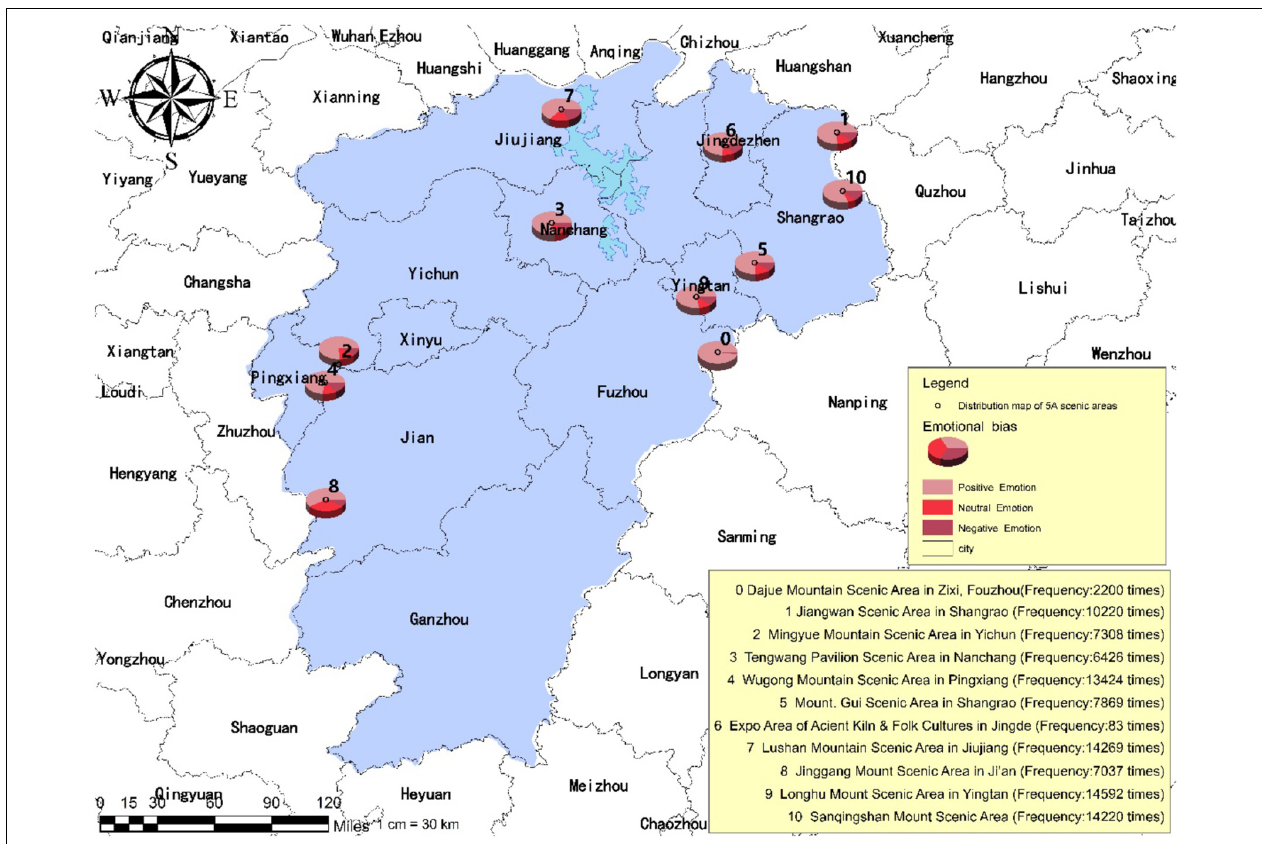
FIGURE 4 | The emotional distribution of tourism destinations in tourist’s psychological perception online posts.